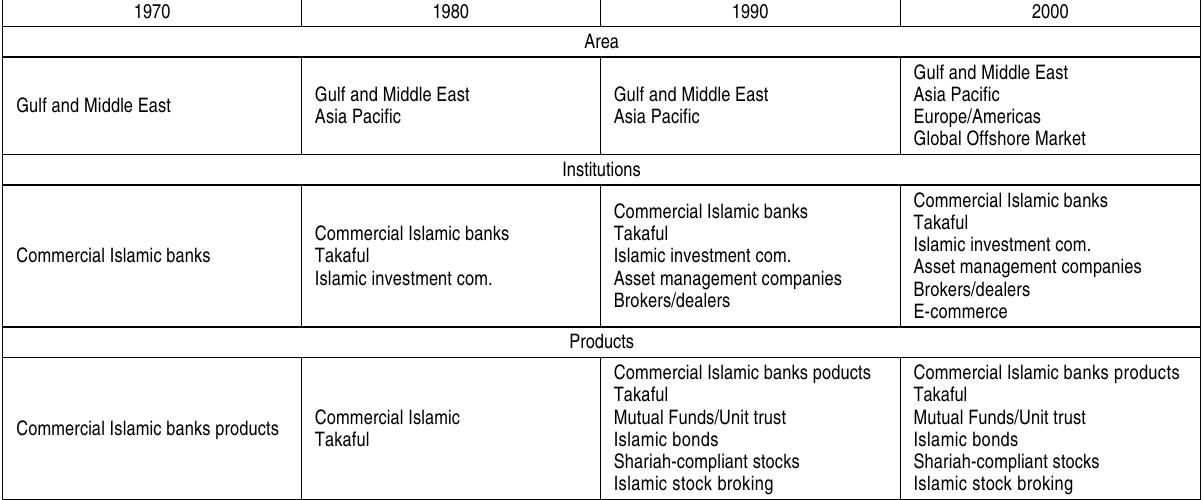
Table 1. Stages of evolution of the Islamic financial